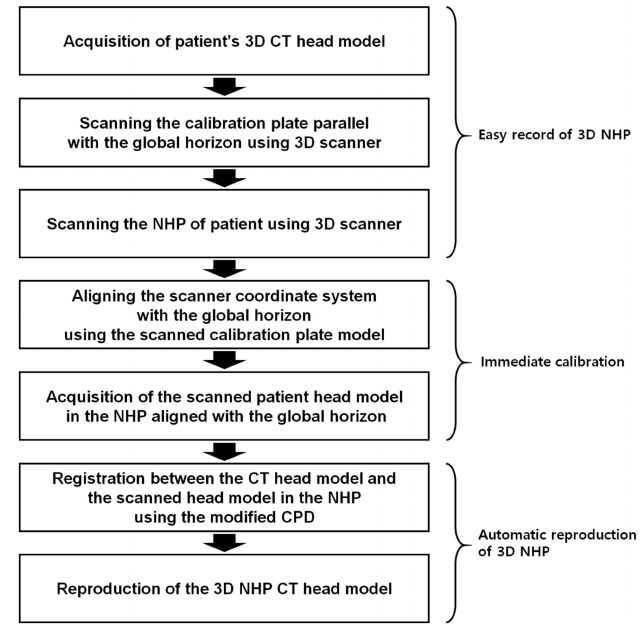
Figure 2. The whole procedure for recording and reproducing the NHP.